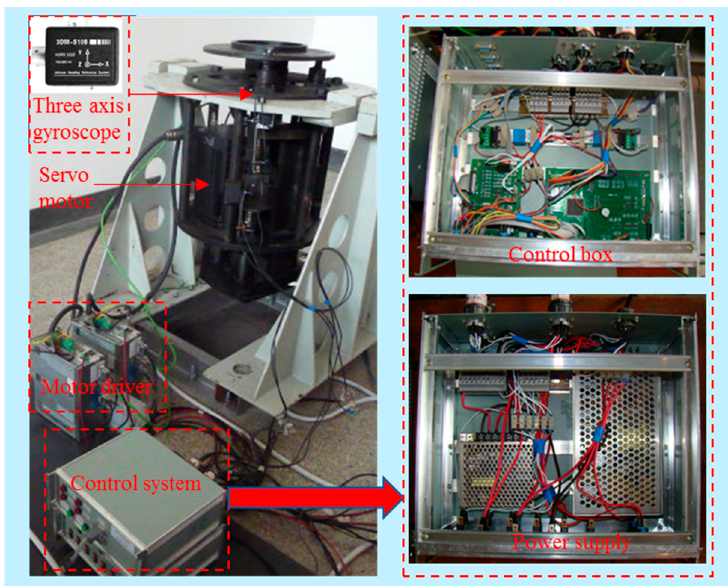
Figure 5. Control system composition of the platform.